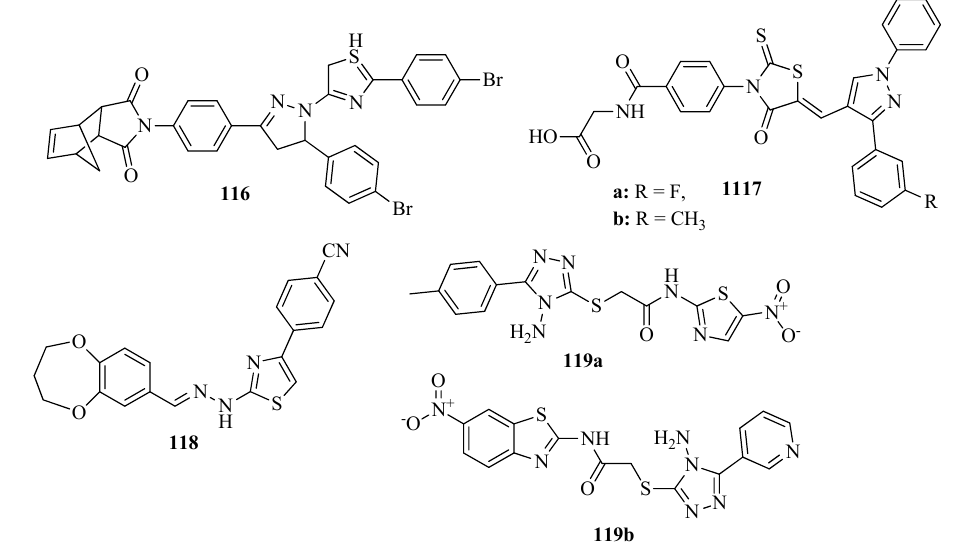
Figure 49. Structures of pyrazolyl–thiazole ( 116 ), 1,3-diarylpyrazol-rhodanine-3-hippuric acid derivatives ( 117 ), -aryl-2-[2-((3,4-dihydro-2 H -1,5-benzodioxepine-7-yl) methylene) hydrazinyl] thiazole ( 118 ), and 2-[(4-amino-5-aryl-4 H -1,2,4-triazol-3-yl)thio]- N -(thiazol/benzothiazol-2-yl)acetamides ( 119a , b ) .